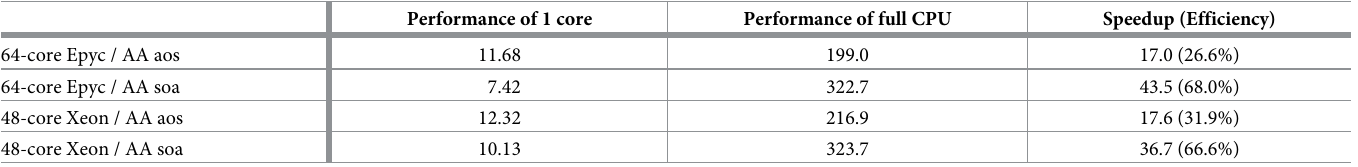
Table 2. Performance and speedup of AMD and Intel CPU with large core counts. Detailed performance figures (in MLups) are provided for the cavity benchmark case with N = 128, BGK collision, and AA-pattern implementation, for the 64-core AMD EPYC CPU and the 48-core Intel Xeon CPU, for program executions using 1 core or all cores. The speedup is the ratio between these two values, and the efficiency is a measure of the scaling performance (100% efficiency stands for an ideal speedup).